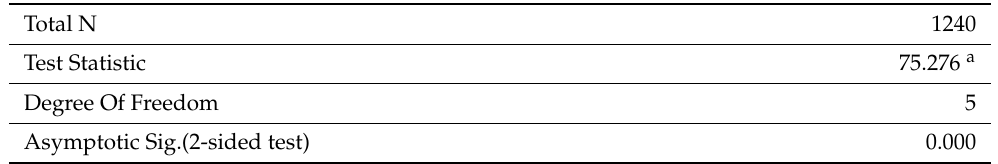
Figure 3. Distribution of viability across different MSN sizes. The boxplot shows the distribution of viability in different size groups. Any data points that are more than 1.5 box-lengths from the edge of their (blue) box are classified by SPSS Statistics as outliers and are illustrated as circular dots. Any data points that are more than 3 box-lengths away from the edge of their box are classified as extreme points (i.e., extreme outliers) and are illustrated with an asterisk (*). Table 2. Independent-Samples Kruskal–Wallis H Test Summary. The table shows the independent samples Kruskal–Wallis H test between MSN diameter size groups’ viability